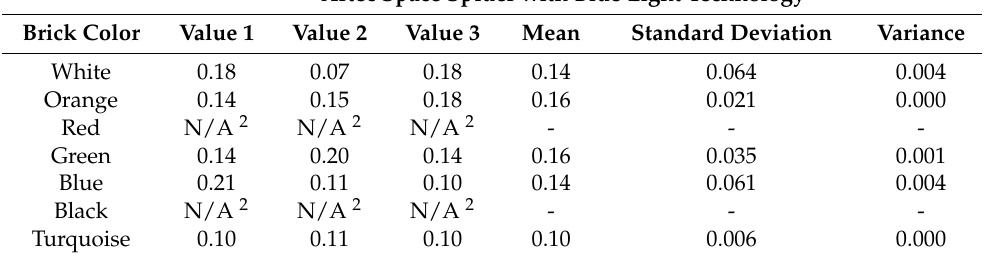
Table A1. Determined flatness values of seven different colored Lego bricks scanned by Artec Space Spider.